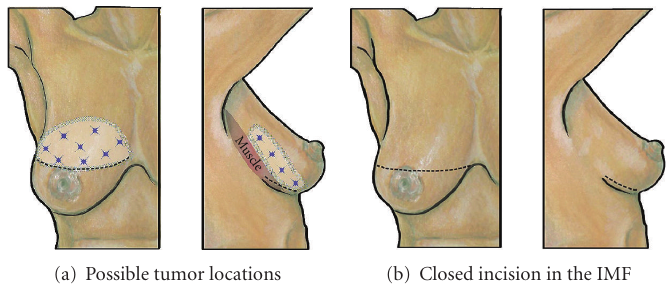
Figure 11: Inframammary Resection. (a) Shows location of inframammary skin incision. “Stars” indicate multiple possible tumor locations suitable for this approach. (b) Shows breast following closure of the inframammary